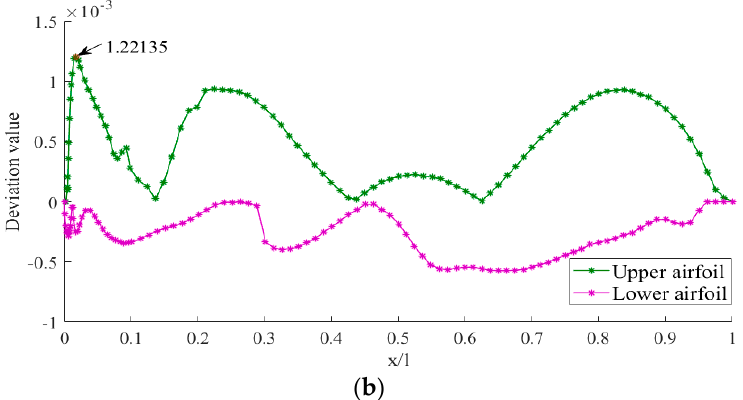
Figure 9. Geometric convergence characteristics of the original airfoil and the fitted airfoil. ( a ) Geometrical characteristic; ( b ) Deviation value. Table 1. Comparative analysis of the fitted airfoils.